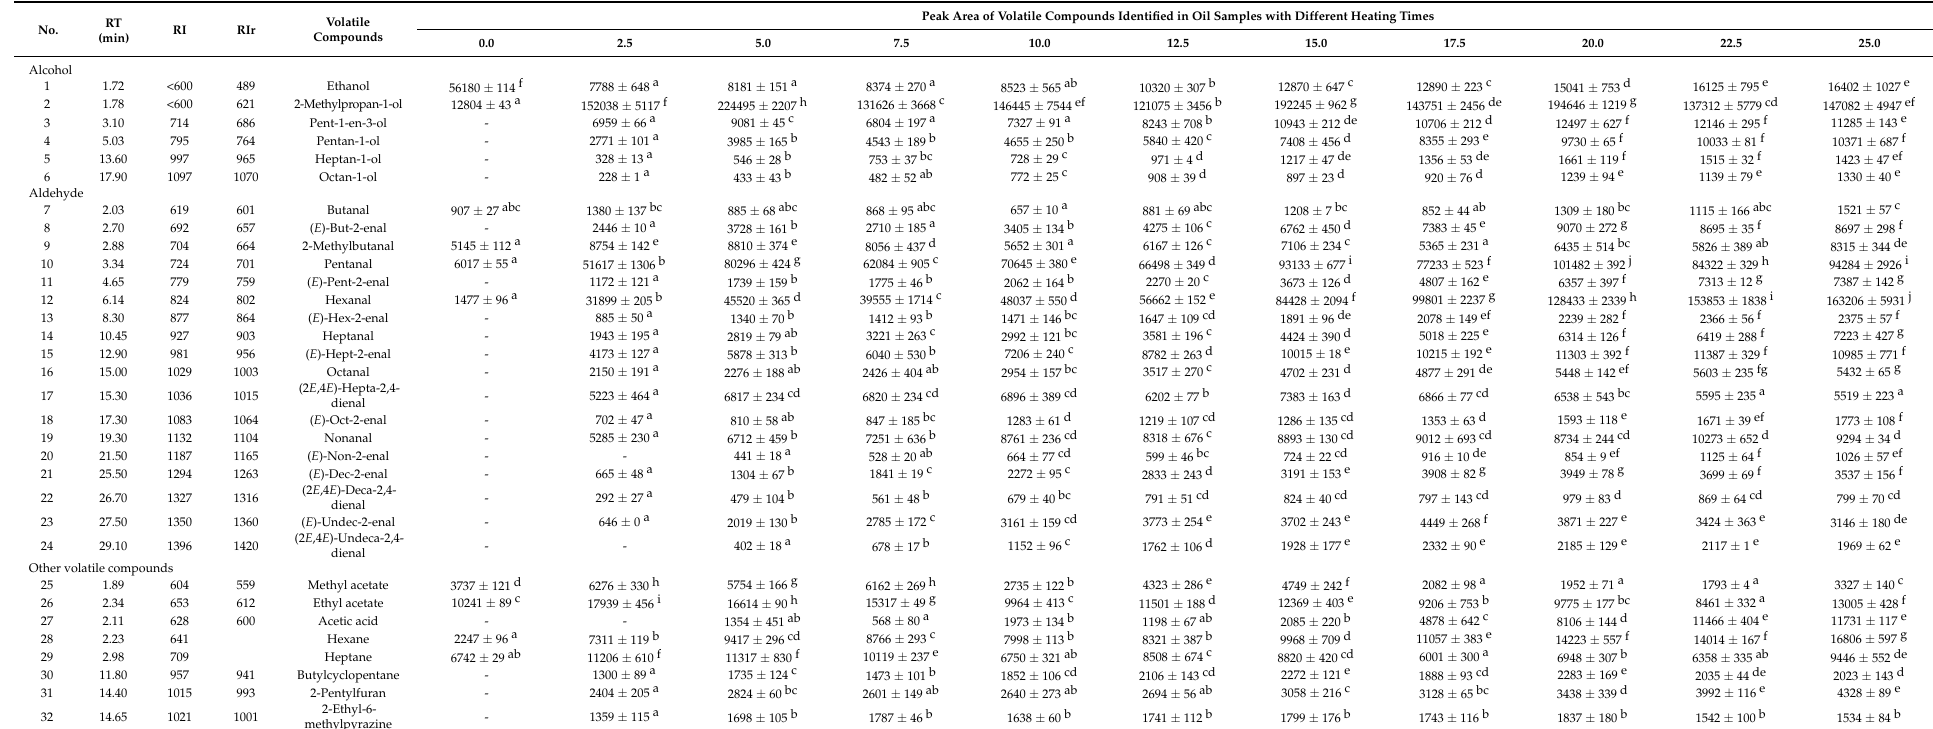
Table 4. The volatile compounds identified in the headspace of the oil